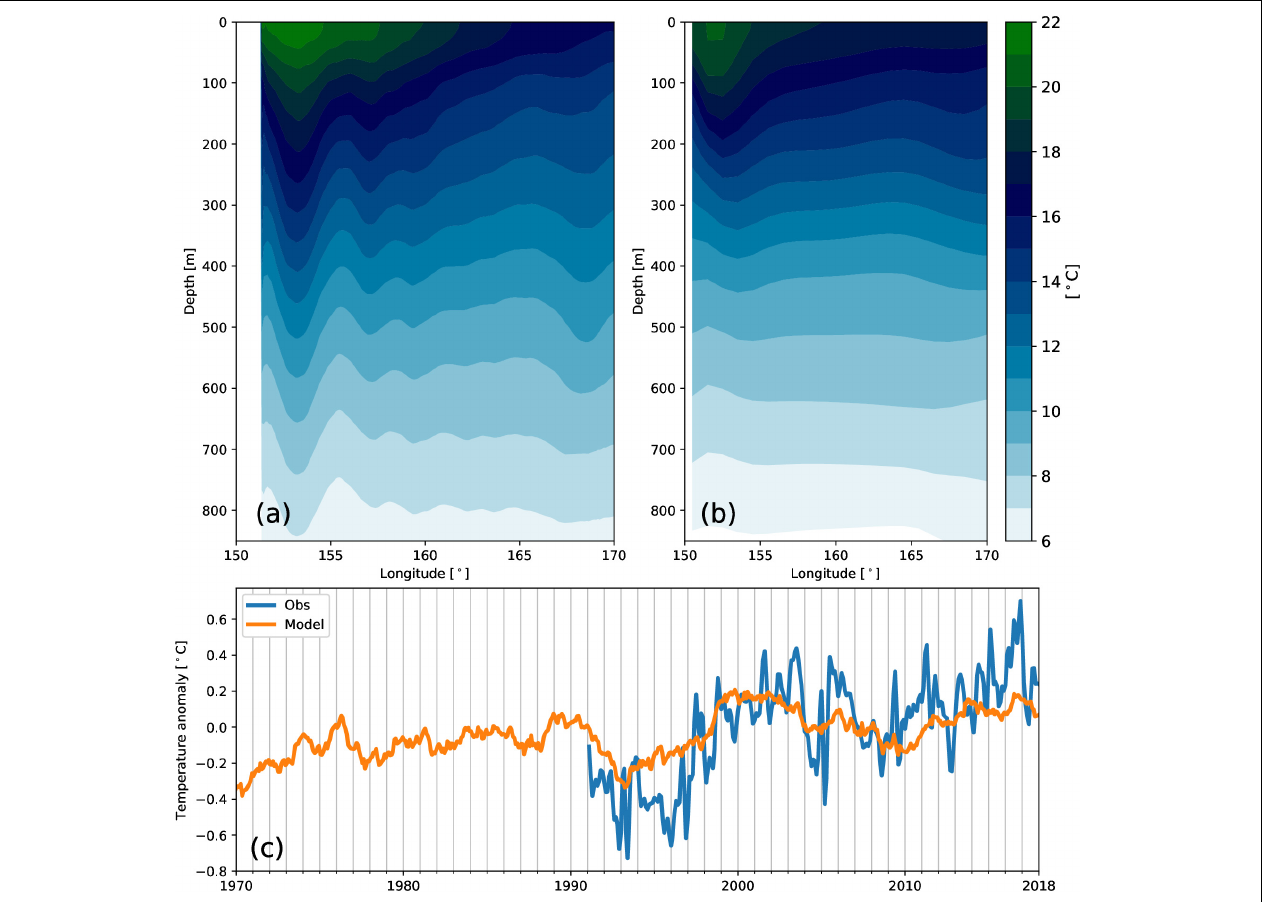
FIGURE 3 | Mean temperature (1991–2018) for the PX34 HRXBT transect (a) between Wellington and Sydney (see Figure 2 ) and (b) model hindcast. (c) top 850 m temperature anomaly over the PX34 HRXBT line from observations (blue) and model (orange). The seasonal cycle has been